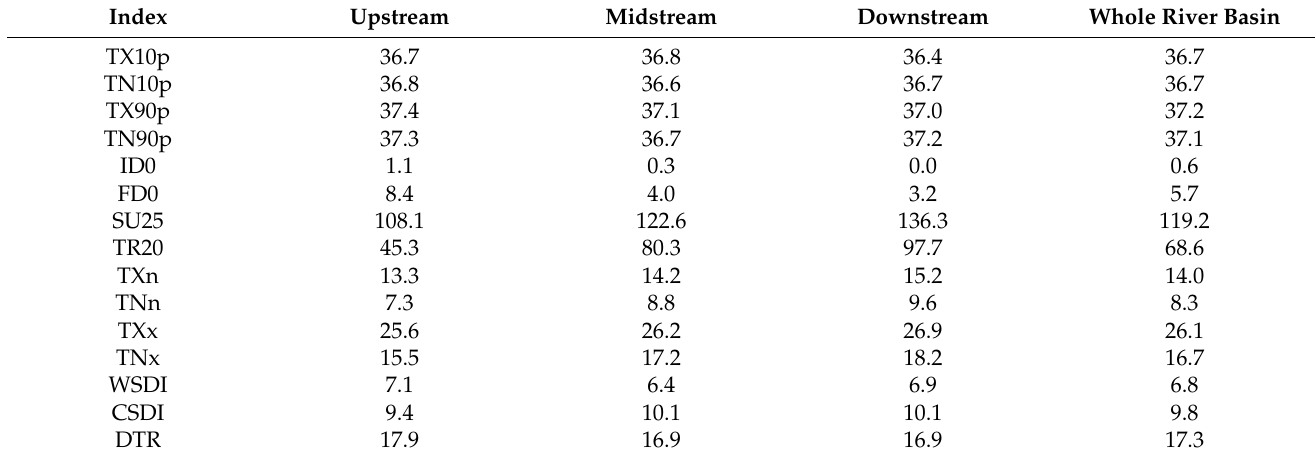
Table 2. Mean extreme temperatures in the Qingyi River basin from 1960 to 2020 ( ◦ C or